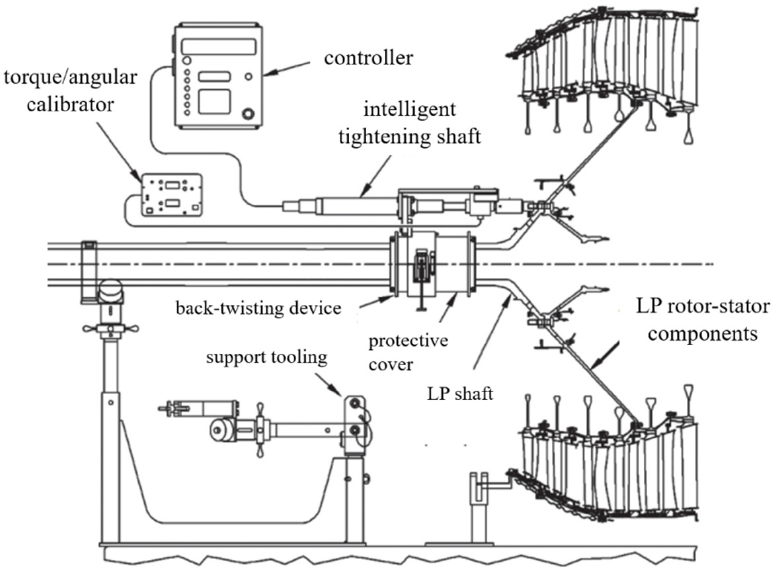
Figure 20. Automated tightening equipment used in a GE90-115B aeroengine [91].